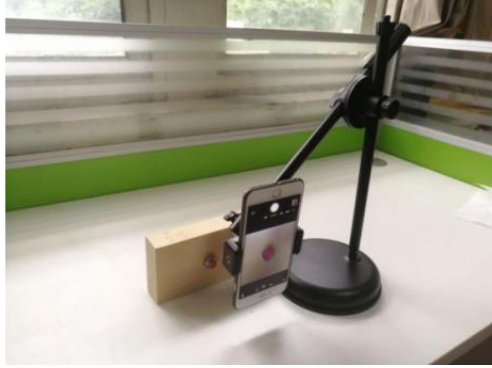
Figure 2. Setup of image collection.